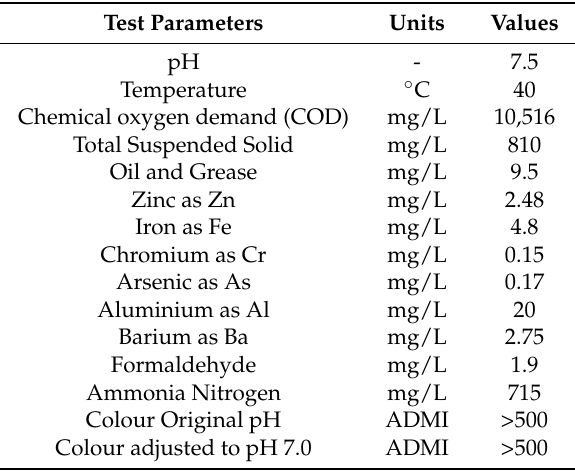
Table 1. Characteristics of landfill